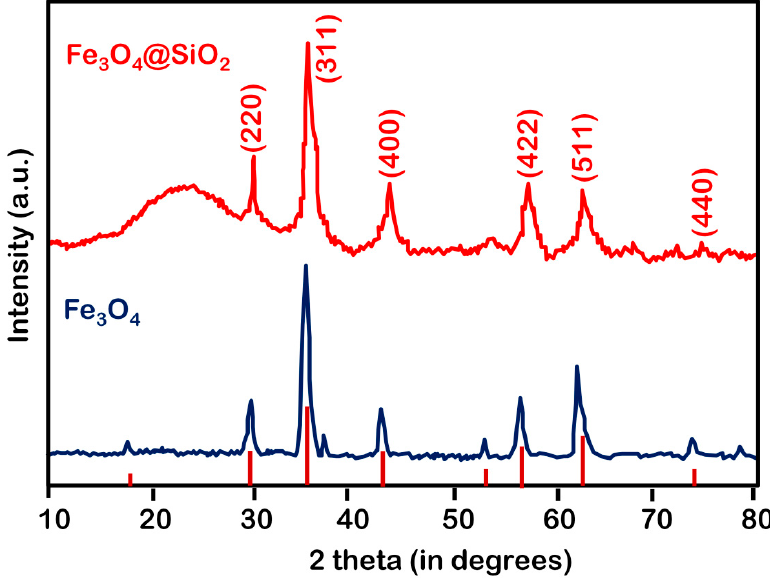
Figure 2. XRD patterns of Fe 3 O 4 and Fe 3 O 4 @SiO 2 MNPs.